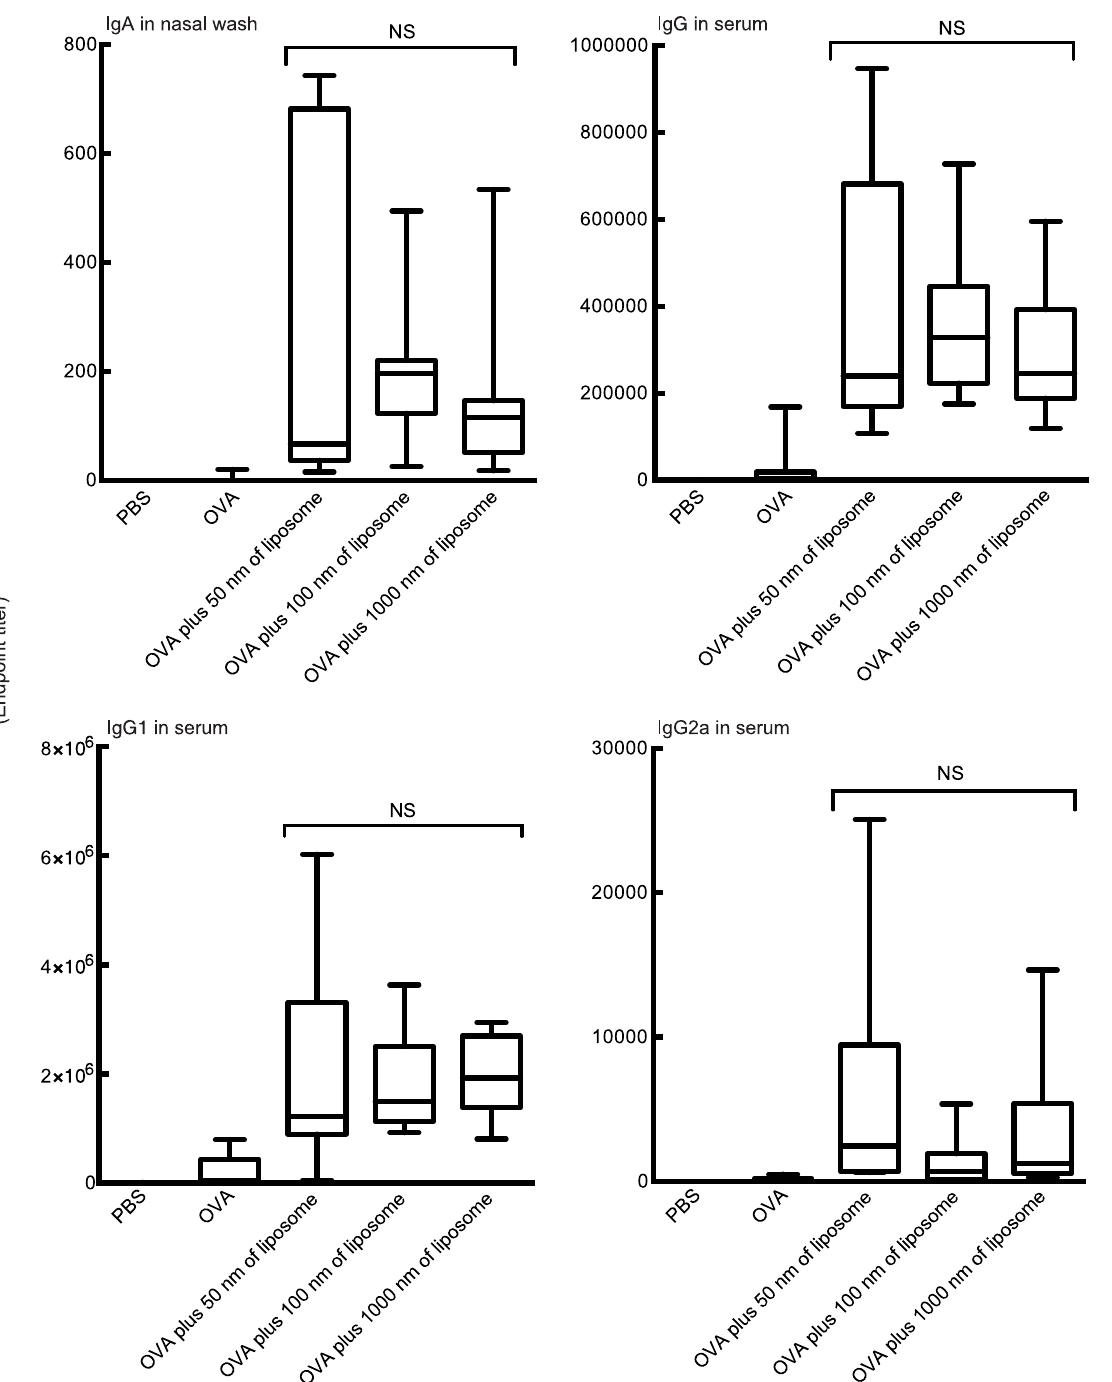
Fig 4. Influence of DOTAP/DC-chol liposome particle size on the mucosal adjuvant effect. BALB/c female mice were immunized intranasally with PBS, and treated with DOTAP/DC-chol liposomes of various particle sizes (0.4 μ mol/mouse) alone, OVA (5 μ g/mouse) alone, or OVA (5 μ g/mouse) plus DOTAP/ DC-chol liposomes of various particle sizes (0.4 μ mol/mouse) on days 0 and 7. Serum and nasal washes were collected on day 14. The anti-OVA IgG, IgG1, and IgG2a levels in serum and anti-OVA IgA level in nasal washes were detected by ELISA assay. The data are obtained from at least three independent experiments. The box-plot shows the median value with the 25th-75th percentiles and the error bars indicate the 5th-95th percentiles. NS: not significant as assessed by the Kruskal – Wallis with Dunn ’ s post – hoc